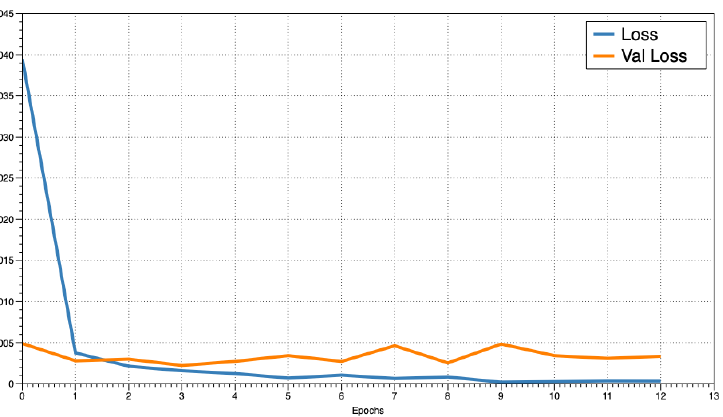
Figure 6. Training Loss versus validation loss for using 100% of the training data where the x -axis is the epoch and the y -axis is the loss.